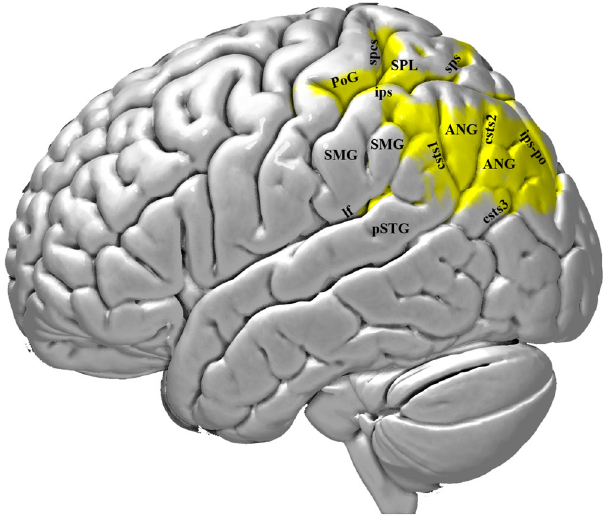
Fig. 6 Lateral view of the left hemisphere lesion of patient TA. The area invaded by the lesion is marked with the yellow color and involves mostly the parietal lobe, including some adjacent posterior temporal and occipital areas. Thus, the lesion is restricted to the dorsal posterior language network, sparing all cortical areas associated with the ventral language network, such as the pars triangularis (area 45) of the inferior frontal gyrus and the anterior temporal areas. The lesion was reconstructed in MNI stereotaxic space and projected on the standard average MNI brain 65,66